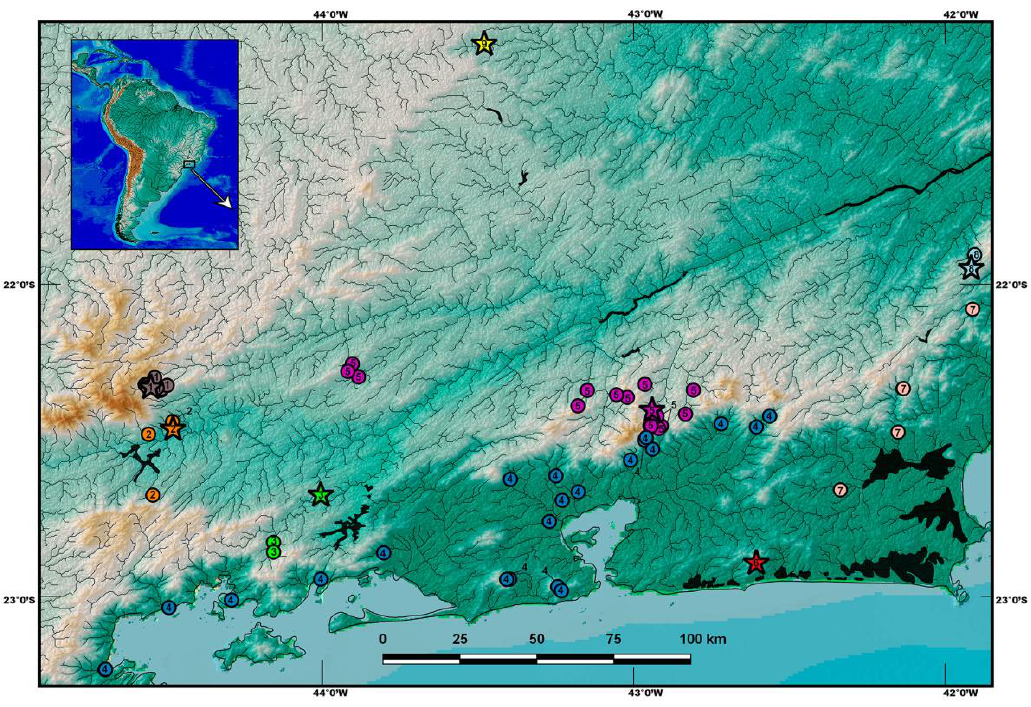
Figure 5. Geographical distribution of species of the Psammocambeva alpha-clade, genus Trichomycterus , in the Rio Paraíba do Sul Area: T. altipombensis Costa, Katz, Vilardo and Mattos, sp. nov. (9, yellow); T. auroguttatus (1, brown); T. goeldii (5, purple); T. jacupiranga (4, blue); T. aff. jacupiranga (7, pink); T. macrophthalmus (3, green); T. puriventris (8, light blue); T. saquarema Costa, Katz, Vilardo and Amorim, sp. nov. (6, red); T. travassosi (2, orange). Stars indicate type localities.